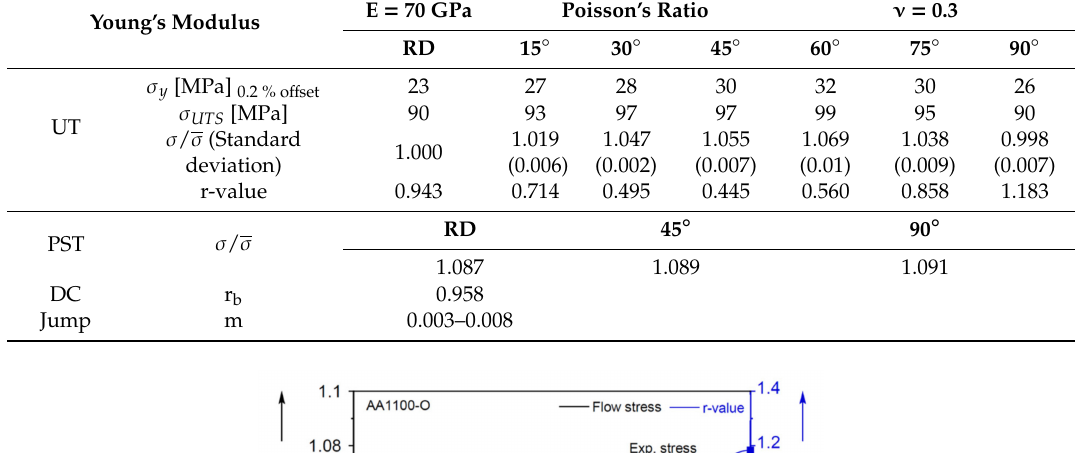
Table 1. Summary of mechanical properties for elasticity and plasticity ( W p = 10 MJ / m 3 ).